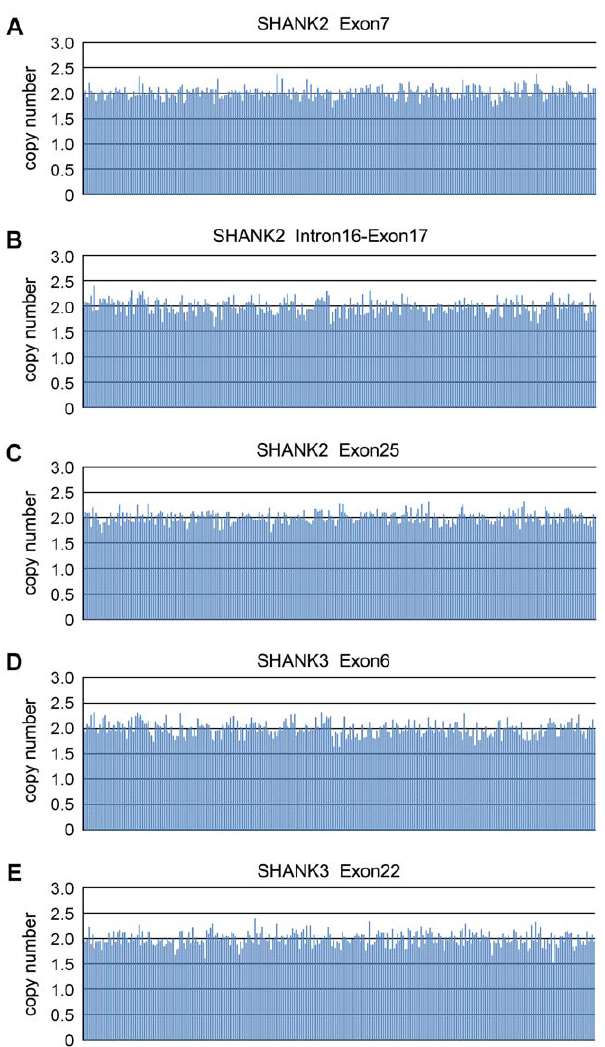
The copy number states of five segments in ASD patients were shown in five panels. Panel A: exon7 of SHANK2 ; Panel B: intron16-exon17 of SHANK2 . Panel C: exon25 of SHANK2 ; Panel D: exon6 of SHANK3 ; Panel E: exon22 of SHANK3 . Each column indicates a patient. All ASD cases showed two copy of